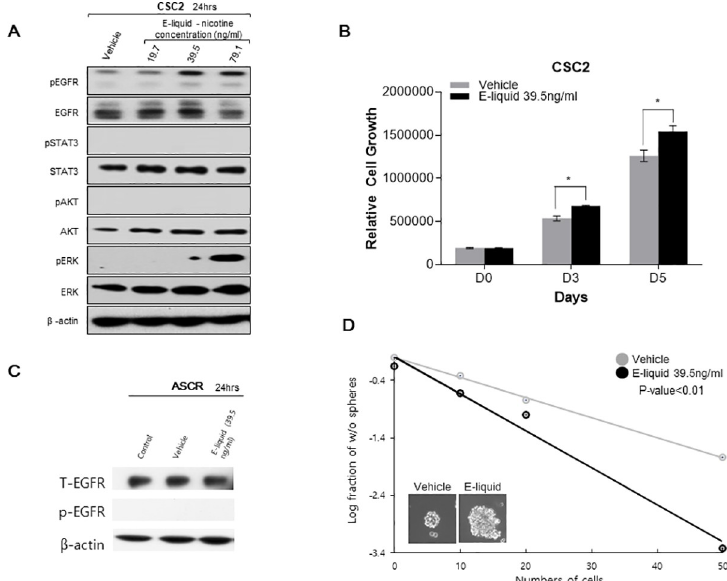
vehicle cells. The data suggested that e-liquid activates specific transducers of EGFR signaling, which influence the growth of brain cancer stem cells via the activation of the ERK pathway (Fig 2A). Surprisingly e-liquid treatment on human astrocytes, which does not express basal p- EGFR levels, did not affect the expression of pEGFR, and EGFR levels. This observation shows